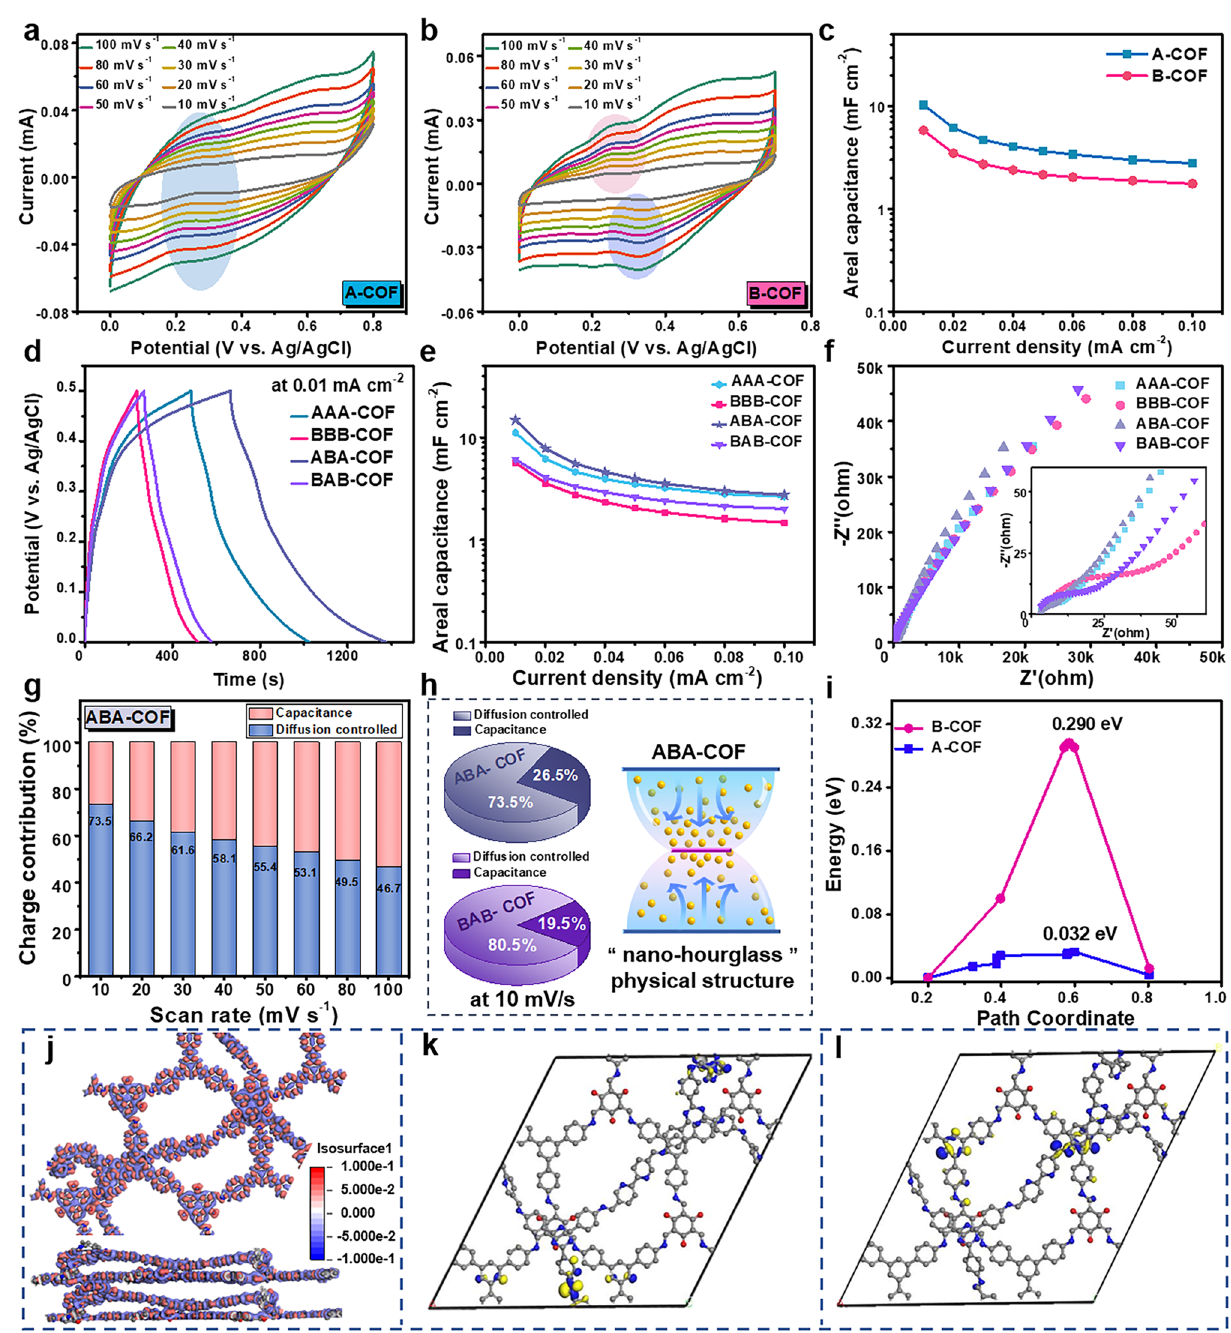
Fig. 2 CV curves of a A-COF film and b B-COF film. c C S of A- and B-COF films. d GCD curves at 0.01 mA cm −2 , e C S and f Nyquist plots of AAA-, BBB-, ABA- and BAB–COF. superlattices. g The diffusion controlled and surface capacitance contribution of ABA–COF superlat- tice at different scan rates. h Pie chart of ABA– and BAB–COF superlattices at 10 mV s −1 and an illustration of ABA–COF superlattice internal “nano-hourglass” physical structure. i The diffusion barrier of protons, j differential charge density distribution (the red region represents charge accumulation, and the blue region indicates charge depletion), and locations of k HOMO and l LUMO in ABA–COF